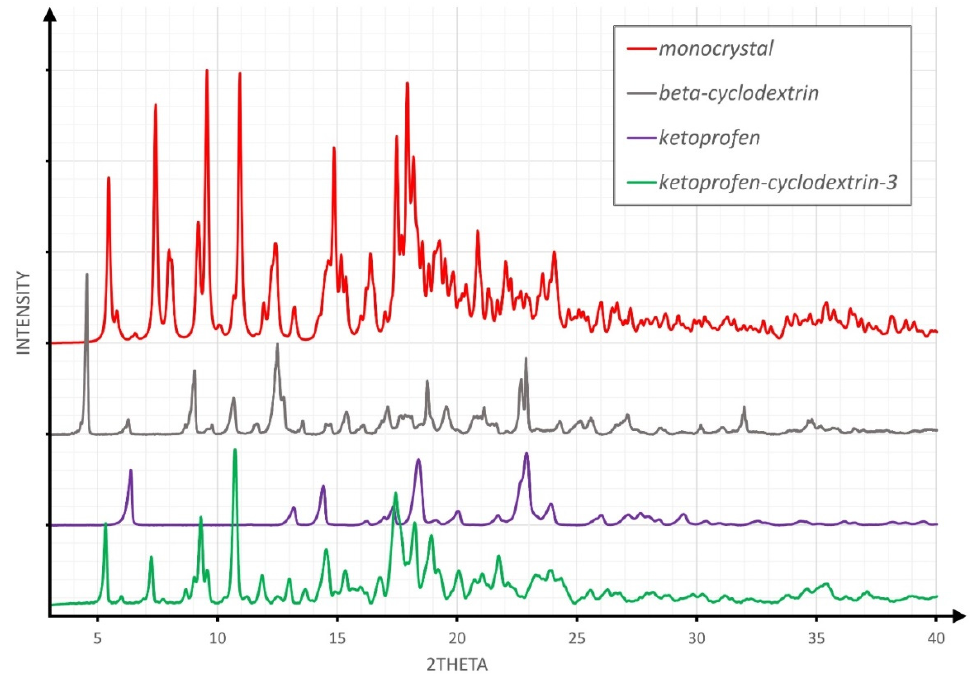
Figure 4. The comparison of XRPD patterns for the product of the heating-under-reflux experiment.